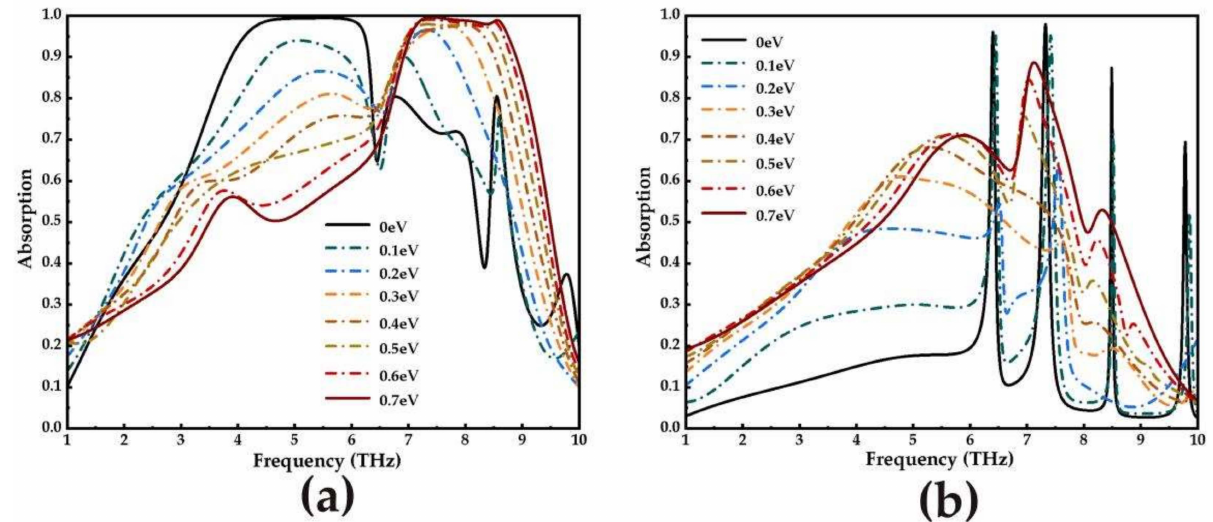
Figure 6. Under different Fermi level conditions of graphene: ( a ) broadband absorption spectrum; ( b ) narrowband absorption